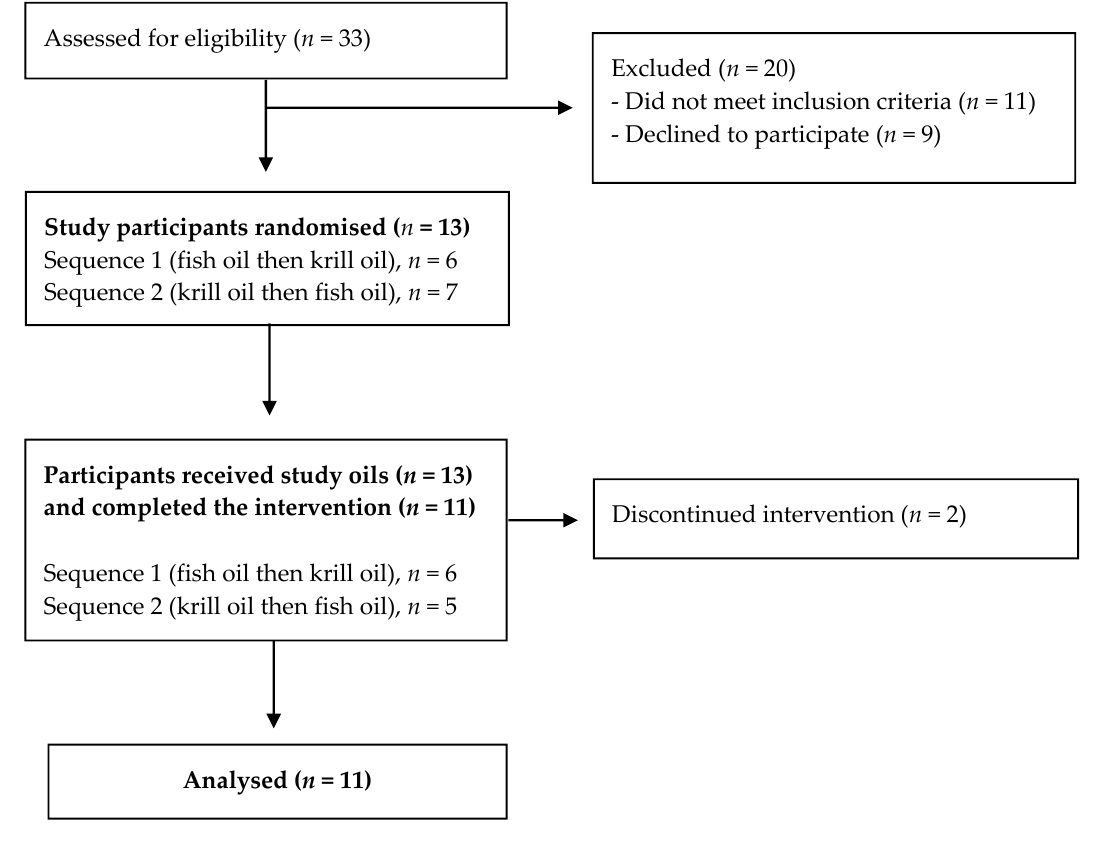
Figure 1. Study design chart n = the number of participants. Each subject received each of the two supplementations (krill oil or fish oil) in randomized order, as shown in the flow chart. There was at least a 4-week washout between two supplementations.